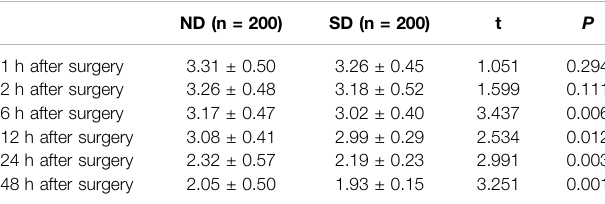
TABLE 3 | Ramsay sedation scores of children at 1, 2, 6, 12, 24, and 48 h after arrival to the ward between Group ND and Group